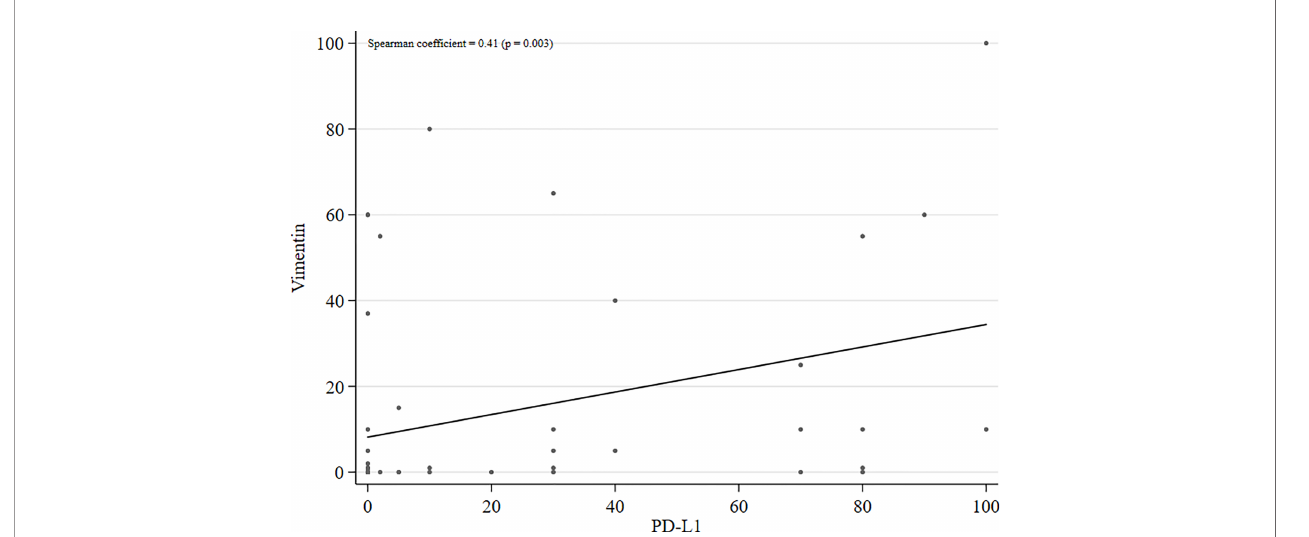
FIGURE 3 | Scatter plot with regression line of PD-L1 and vimentin expression